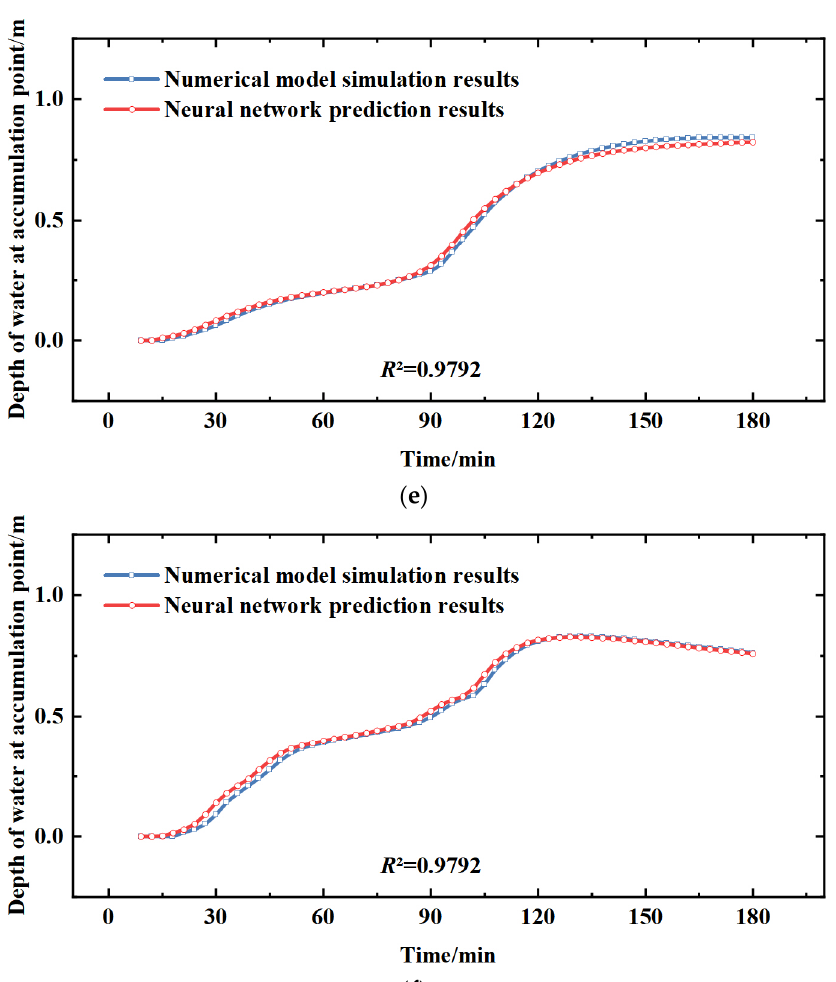
Figure 5. Comparison of simulation results of design rainfall scenarios based on the storm intensity formula. ( a ) Intersection of Construction Road and Yinzhu Road, ( b ) Bayi Road North, ( c ) Zhou Shi gate, ( d ) Area around Sanlian Hang, ( e ) Yellow River Road West, ( f ) Zhong Yuan Road South.